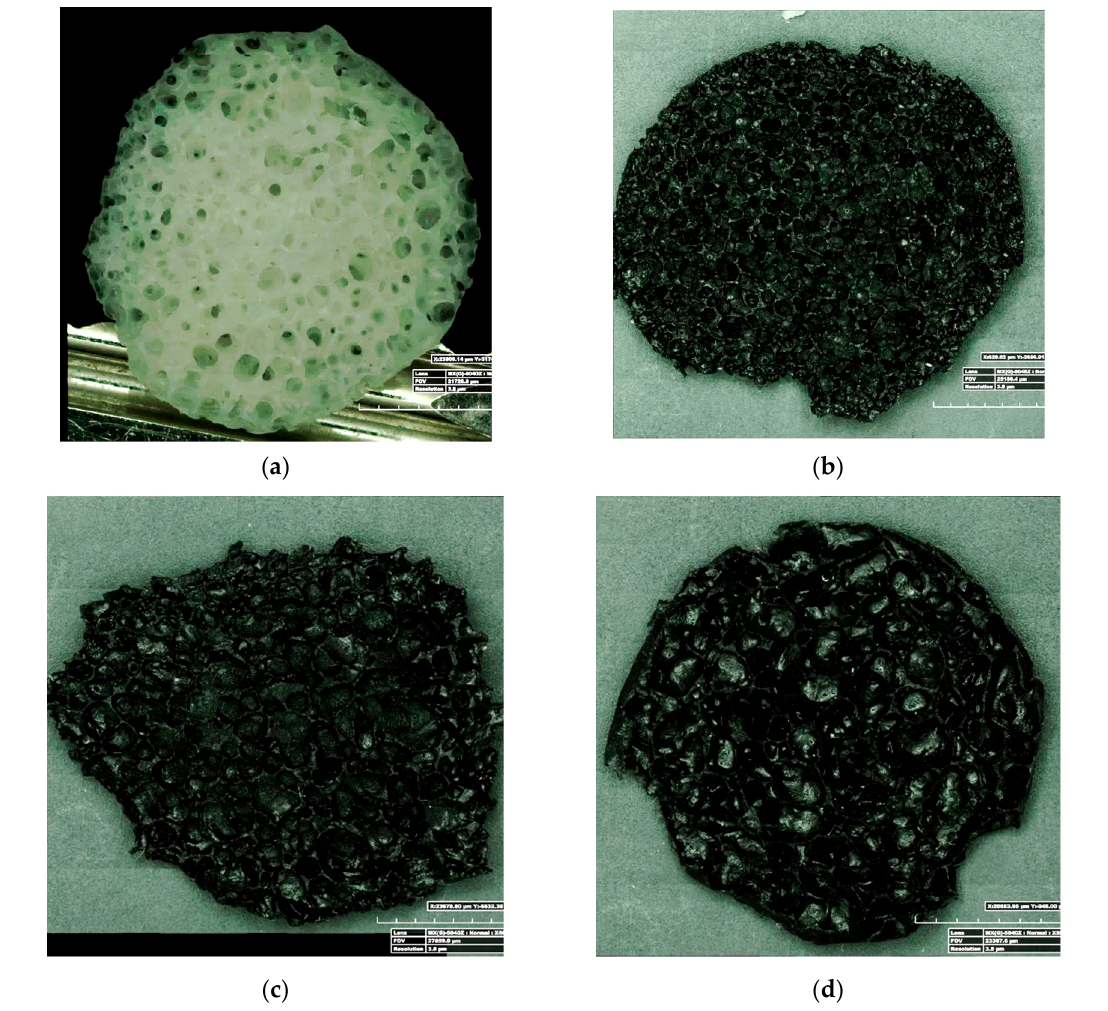
Figure 6. Cross-section optical images of ( a ) F-AR, ( b ) F-CNT0, ( c ) F-CNT22, and ( d ) F-CNT36 foams.